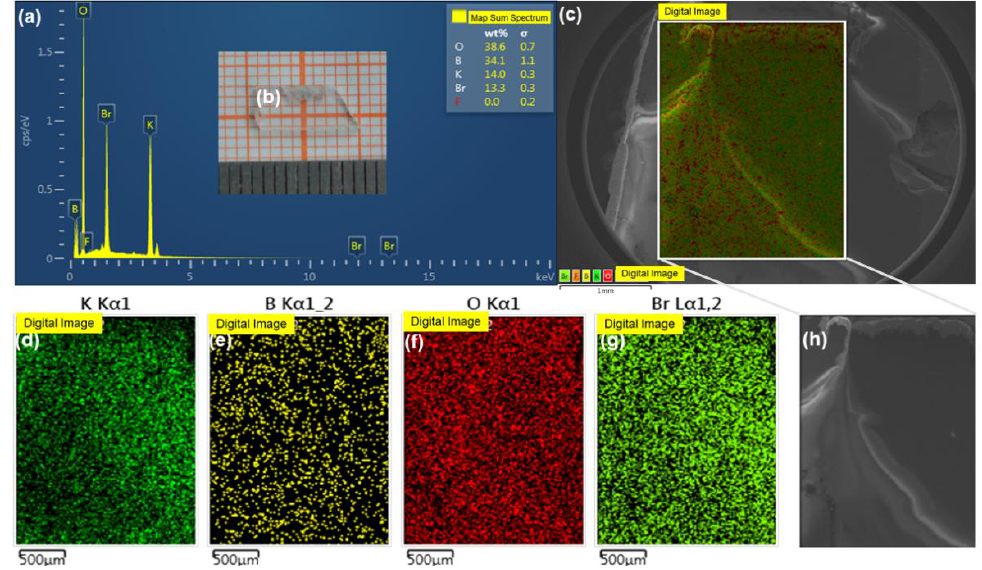
Figure 5. Element analysis of KBOB-LF. ( a ) Element analysis photography. ( b ) The object picture of KBOB crystal ( c ) Surface topography photography ( d – g ) EDS digital images of elements K, B, O, and Br, respectively. ( h ) The SEM photograph of KBOB-LF.